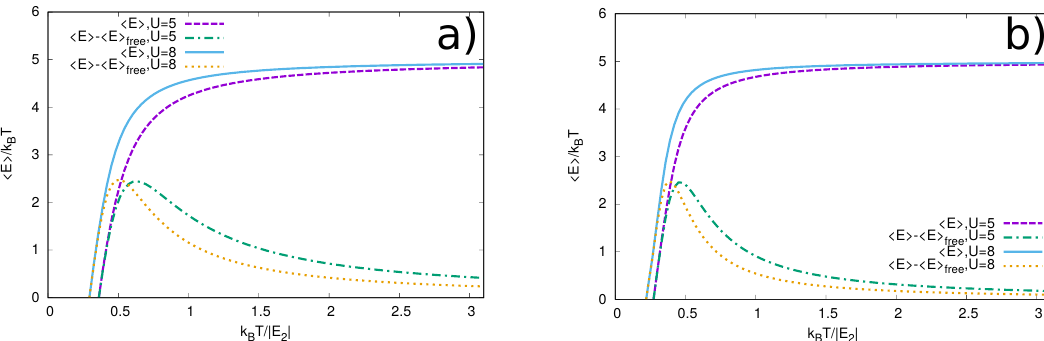
Figure 5. This plot shows the energy of the one-particle-per-layer system, (cid:104) E (cid:105) , and the difference of the energy with the energy of the system of completely free particles, (cid:104) E (cid:105) − (cid:104) E (cid:105) free . Panel ( a ) shows curves for different U with oscillator length values being twice the inter-layer distance, and in panel ( b ) the √ oscillator length is 10 the inter-layer distance. The energy curves all start at large negative energies because of the finite binding energy at low temperatures, then approach the high-temperature limit of 5 k B T (the equipartition of energy limit for this system). The curves showing the difference of energies start to separate from the energy curve at k B T / E 2 ≈ 0.25 to 0.4 as the free-particle state becomes populated before rapidly turning over and descending towards the high-temperature limit of